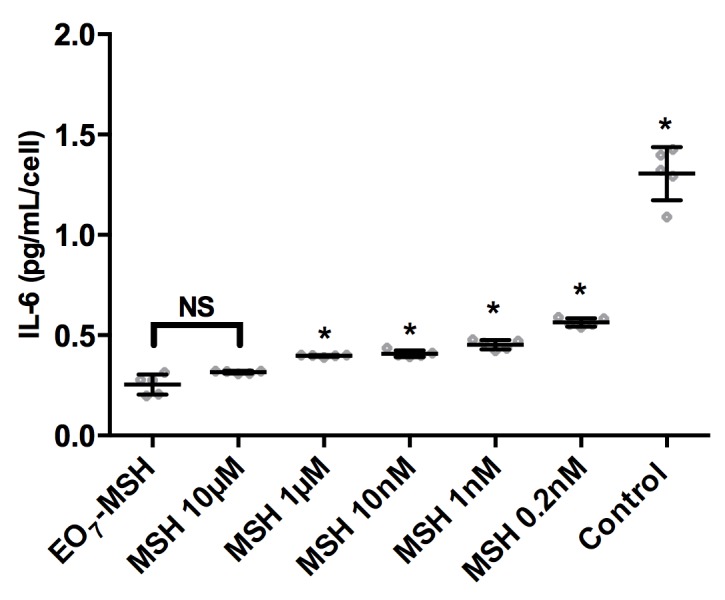
Soluble versus surface bound α-MSH.Effect of immobilized α-MSH (EO7-MHS) on LPS induced endothelial IL-6 production compared to cells re-plated onto culture dishes in culture medium containing either no soluble α-MSH (Control) or soluble α-MSH in concentration ranging from 0.2 nM to 10 μM. Error bars represent standard deviations. A Bonferroni test relative to EO7-MSH vs. other treatments was performed. Differences were considered significant for p<0.01 and marked with an asterisk. The number of replicates is n = 5.